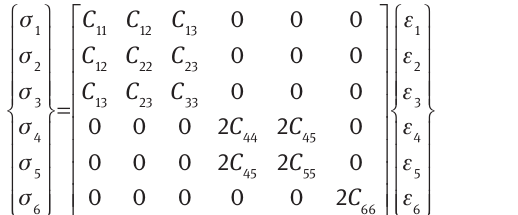
Figure 1 Laminated cylindrical shell of M